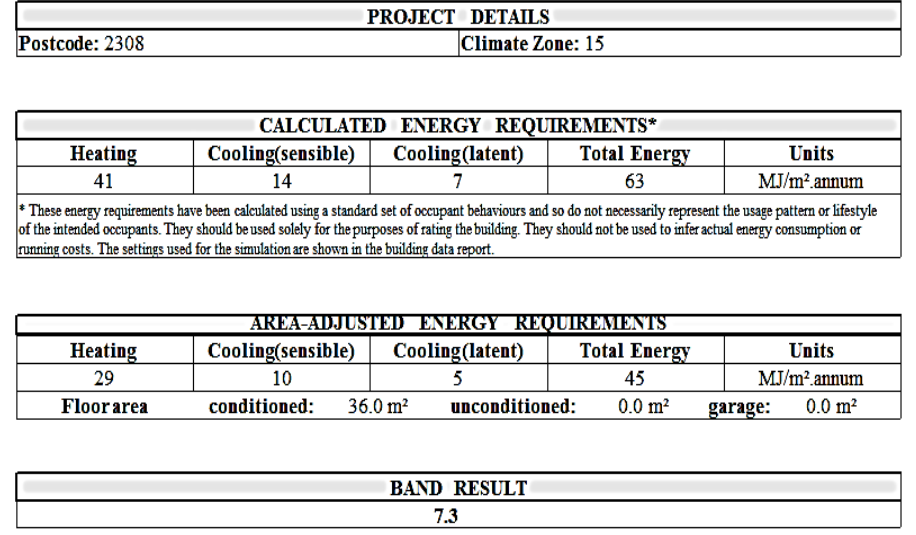
Fig. 3. An example of AccuRate certificate which shows the annual heating and cooling energy requirements and star ratings for the InsBV module [7]. Note: the sensible cooling load refers to the dry-bulb temperature of the building and the latent cooling load refers to the wet-bulb temperature. All modules experienced the worst thermal performance in winter months where the main energy was required for heating. For example, the InsBV module required 29 MJ/m 2 per annum for heating in winter time. The annual heating energy requirement for all the modules is shown in Fig. 4.